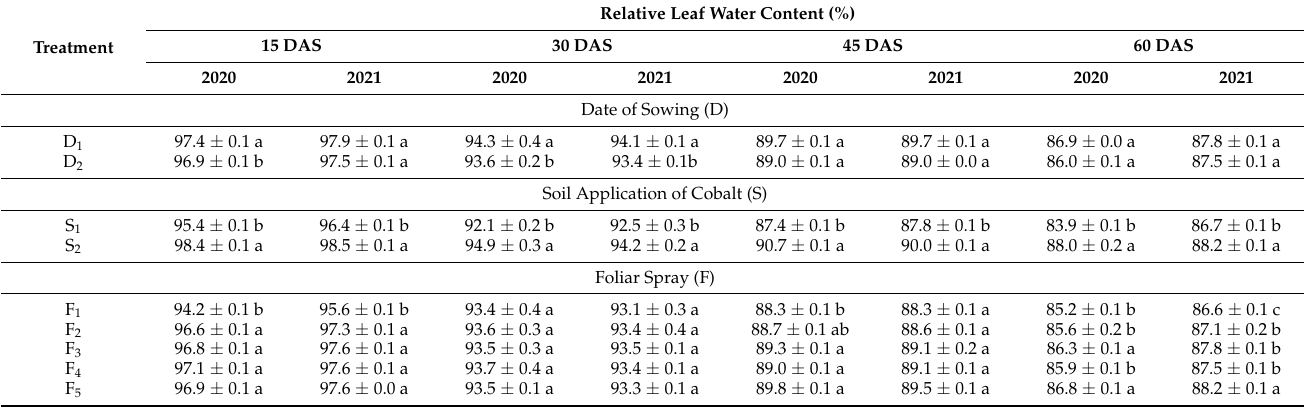
Table 7. Relative leaf water content at different growth